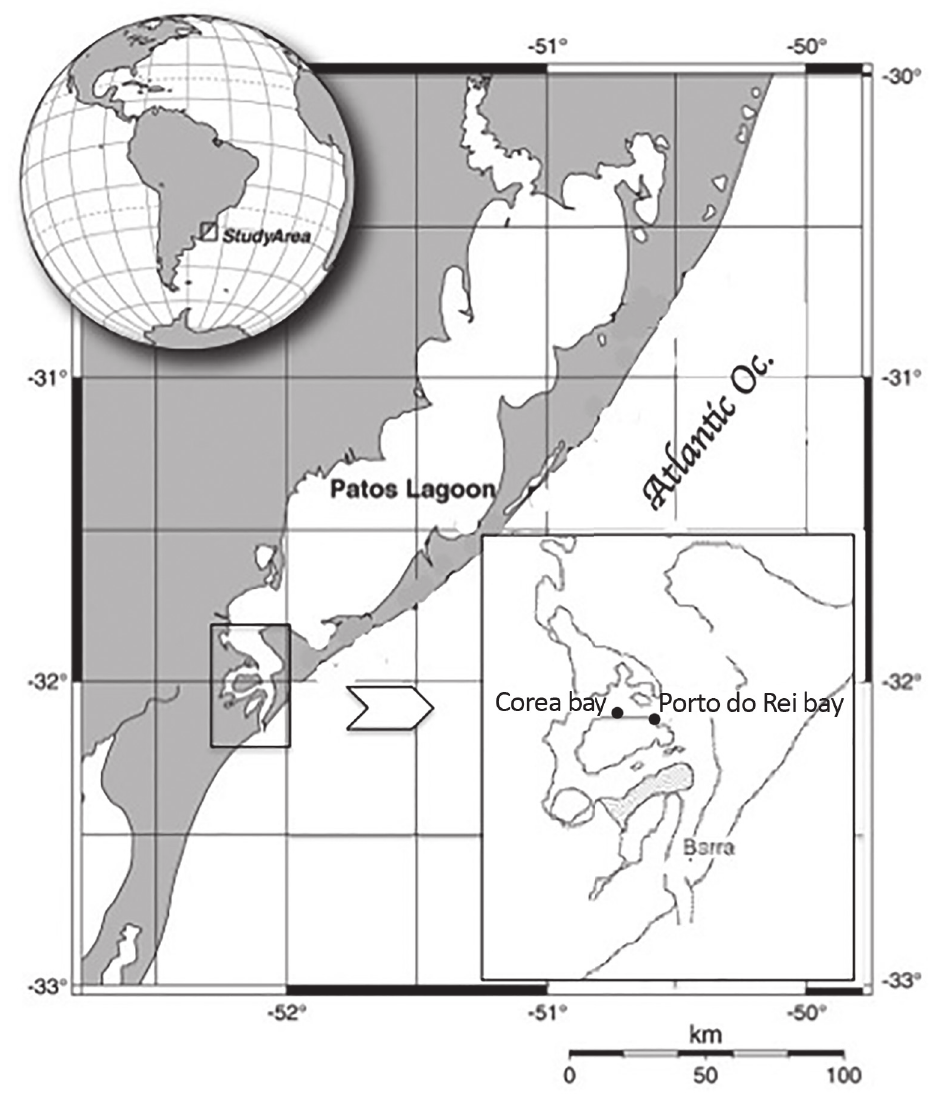
Figure 1 - Study area in the Patos Lagoon estuary, Southern Brazil: Coreia and Porto do Rei